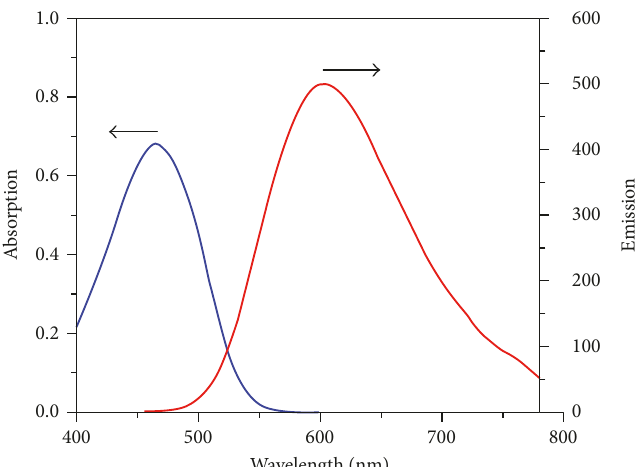
Figure 2: Absorption (blue line) and emission (red line) spectra of CL1 in ethanol in arbitrary units showing values of 468nm and 618nm,